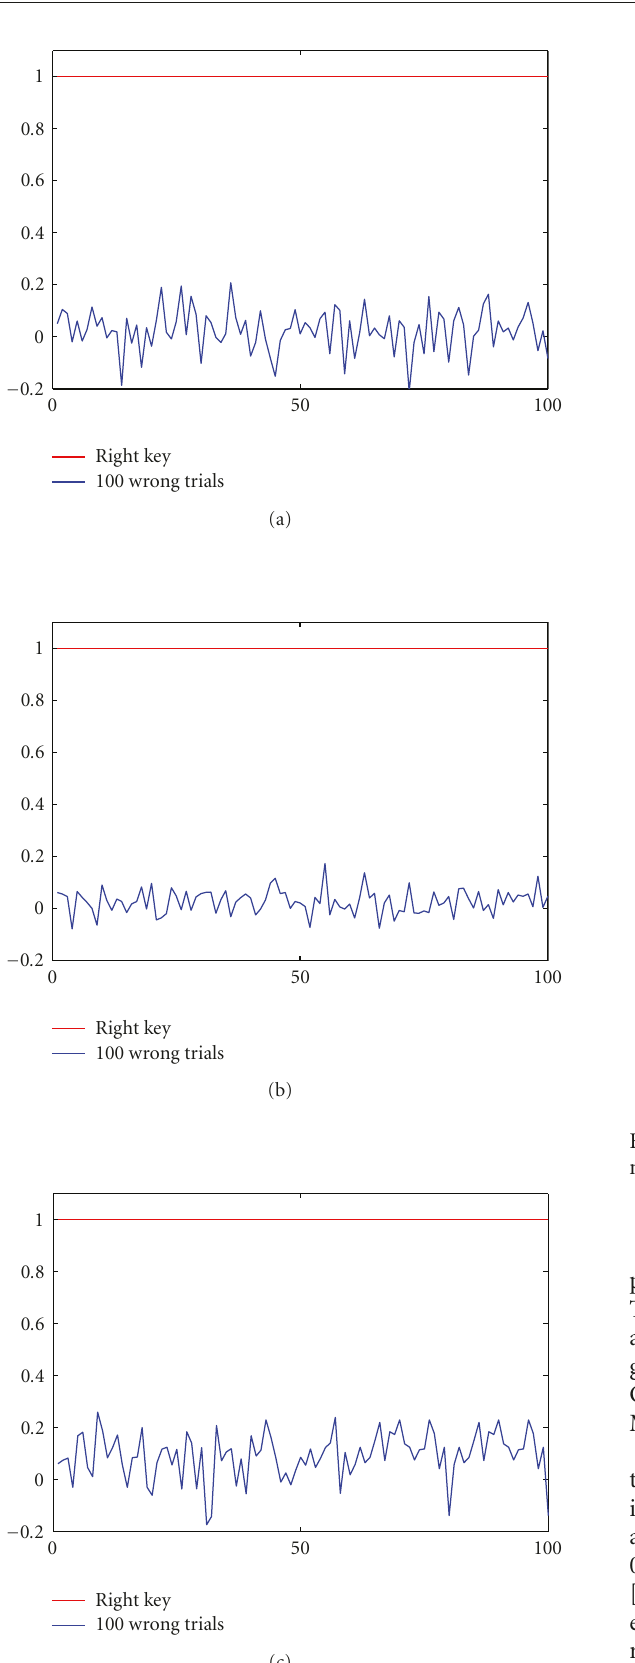
Figure 4: Detection results for three out of all tested signals.